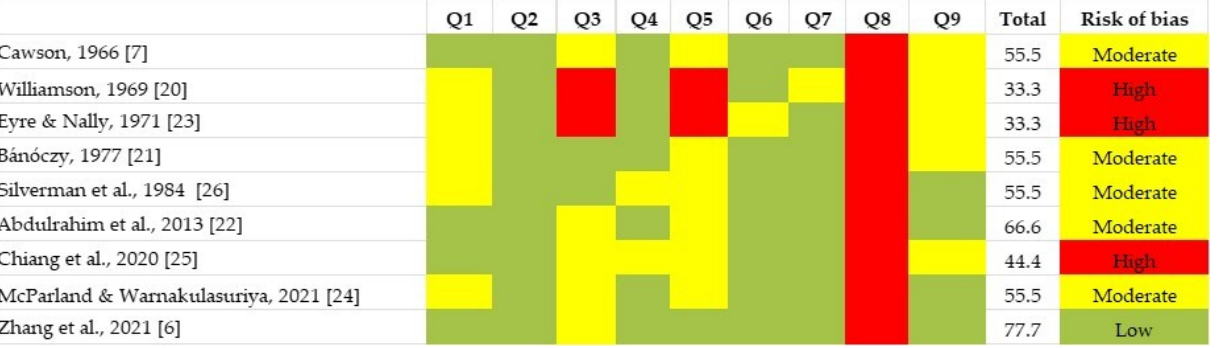
Figure 2. Quality plot graphically depicting the risk of bias among individual studies, assessed using Joanna Briggs Institute Critical Appraisal Checklist designed for systematic reviews addressing prevalence, cumulative incidence questions, and/or for proportion meta-analyses [6,7,20–26]. Overall, the cumulative pooled prevalence of MT in CHC was 12.1% (95% CI, 4.1–19.8%; I 2 = 78.27%, Q test p value = 0.002) (Figure 3A). A remarkable asymmetry could be seen in the forest plot, indicating a skewness to the right (Figure 3B). Egger’s regression test confirmed the existence of a publication bias (pEgger = 0.001). We stratified the sub- group analysis by either Asian or non-Asian, and the heterogeneity subsided for Asian studies (I 2 = 31.03%), while the pooled estimate was also modified meaningfully [pooled proportion: 6.5% (95% CI, − 1.5–14.5)]. On the other hand, in the non-Asian subgroup, heterogeneity was extremely large (I 2 = 82.77). Stratification by a RoB assessment